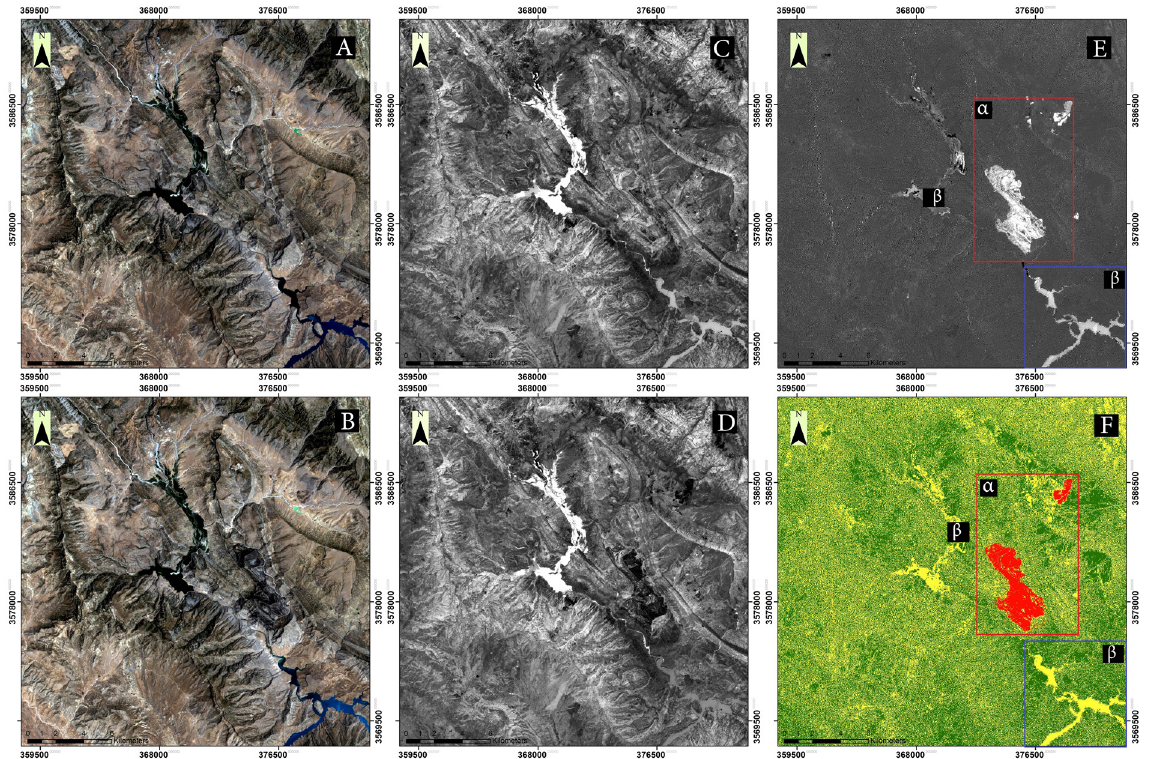
Figure 5. Generate the fire map of 20. July 2019 using the NBR index: A) Landsat 8/OLI pre-wildfire image (RGB); B) Landsat 8/ OLI post-wildfire image (RGB); C) pre-fire NBR index; D) post-fire NBR index; E) dNBR result; F) fire map from dNBR classifica- tion, where (α) represents burned areas and (β) represents faults that identify areas of clouds and waters as moderately burned